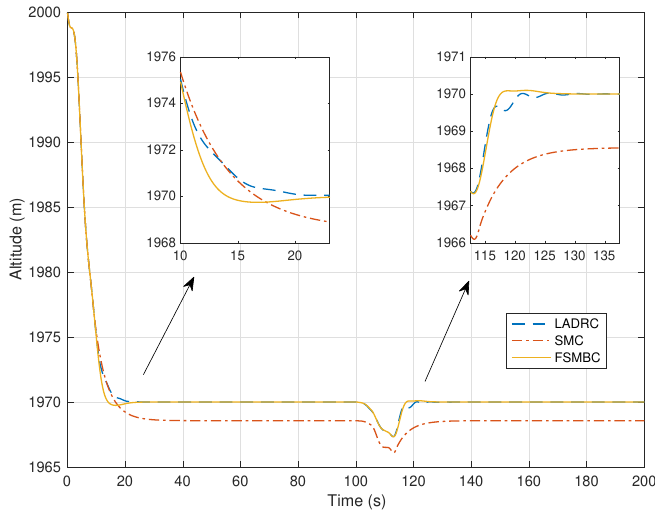
Figure 6. Simulation results of altitude control by LADRC, SMC, and